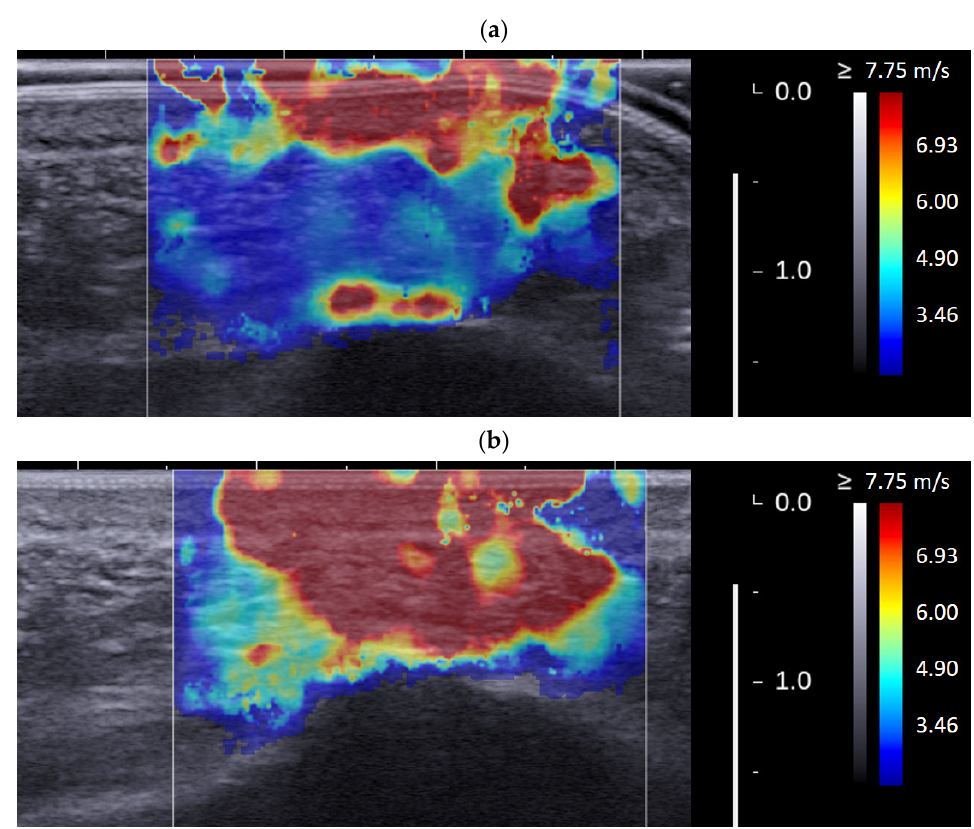
Figure 6. The statistical results. For both the microchamber (MIC) and macrochamber (MAC) layers of the heel pad, the shear wave speed decreased and thickness increased significantly with a plastic heel cup (C) compared with the condition without a plastic heel cup (NC). The asterisk symbol indicates a statistically significant difference.